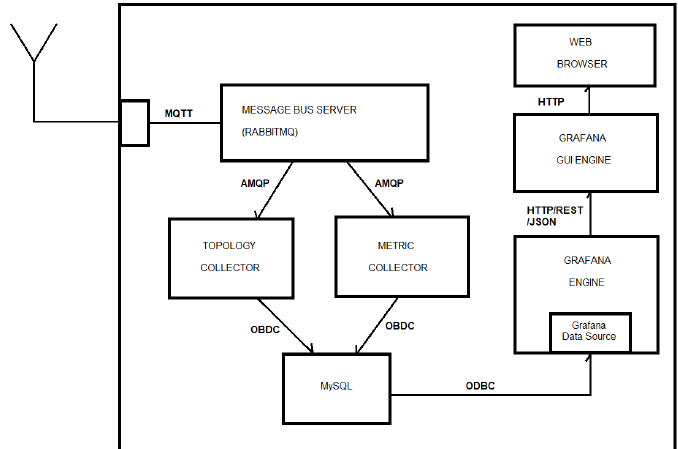
Figure 12. Farmhouse system schema.